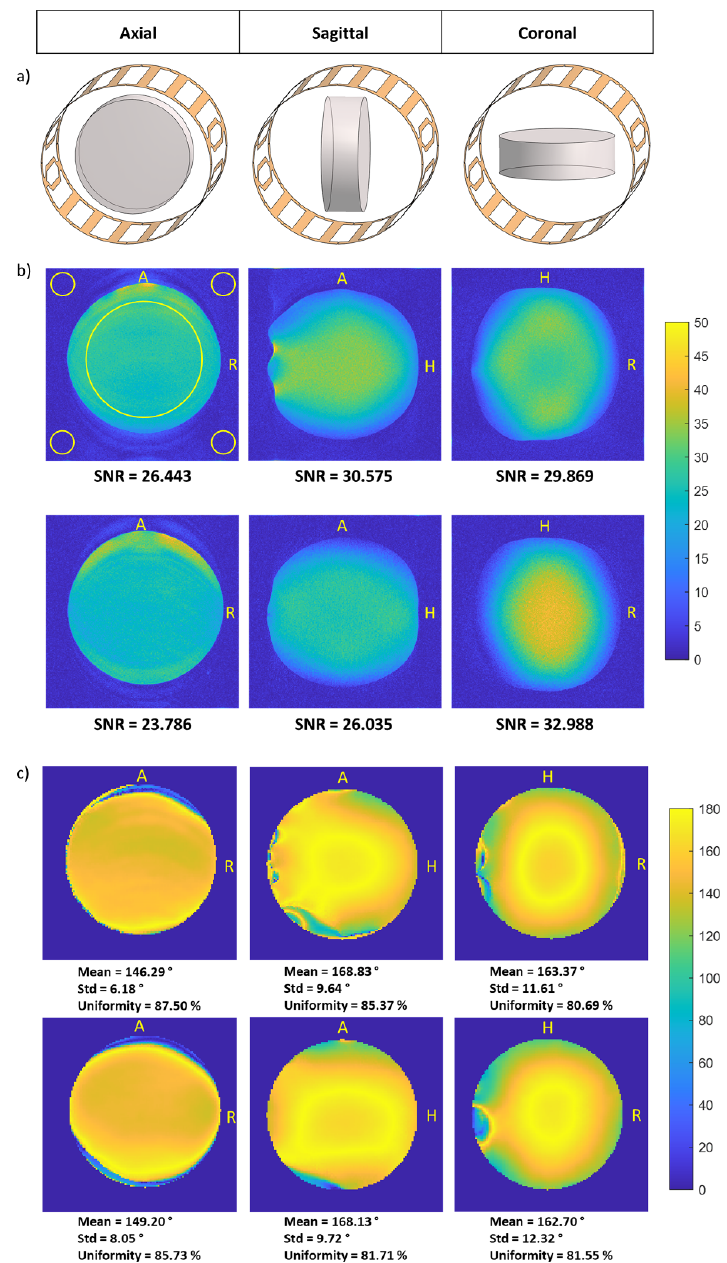
Figure 4. ( a ) Illustration of experimental setup of cylindrical uniform phantom in axial, sagittal, and coronal orientations inside magnet bore; ( b ) SNR map acquired using T1w spin echo sequence; ( c ) FA map (nominal FA—180°) acquired using composite spin echo sequence in commercial circular birdcage (top row) and constructed split-type elliptical birdcage (bottom row). Note that values written below each map were calculated in 2D ROI of 30 cm in diameter.